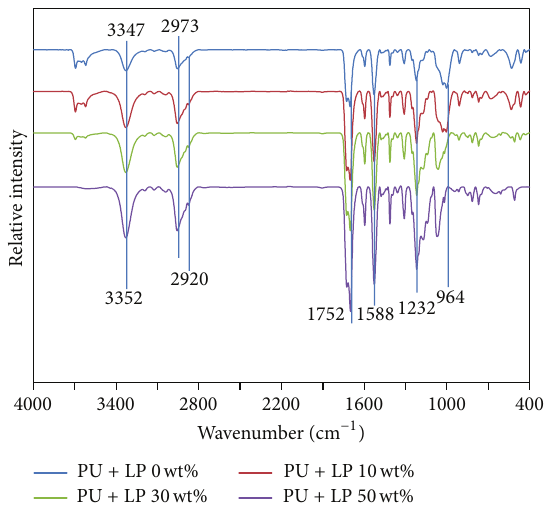
Figure 6: FTIR spectra of different nanofibrous mats.